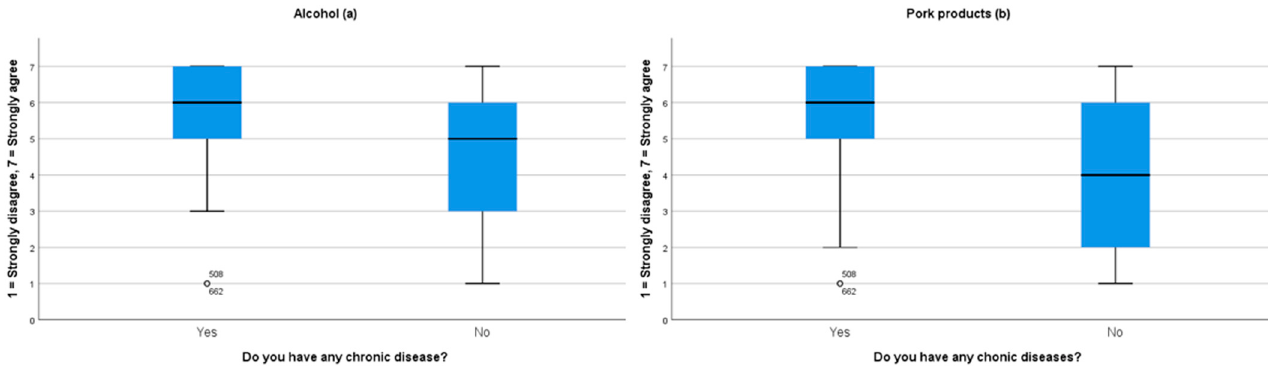
Figure 3. This figure represents the respondents’ answers to whether they would be willing take medication containing ( a ) alcohol or ( b ) pork products in cases when there are no other alternatives to these medicines.